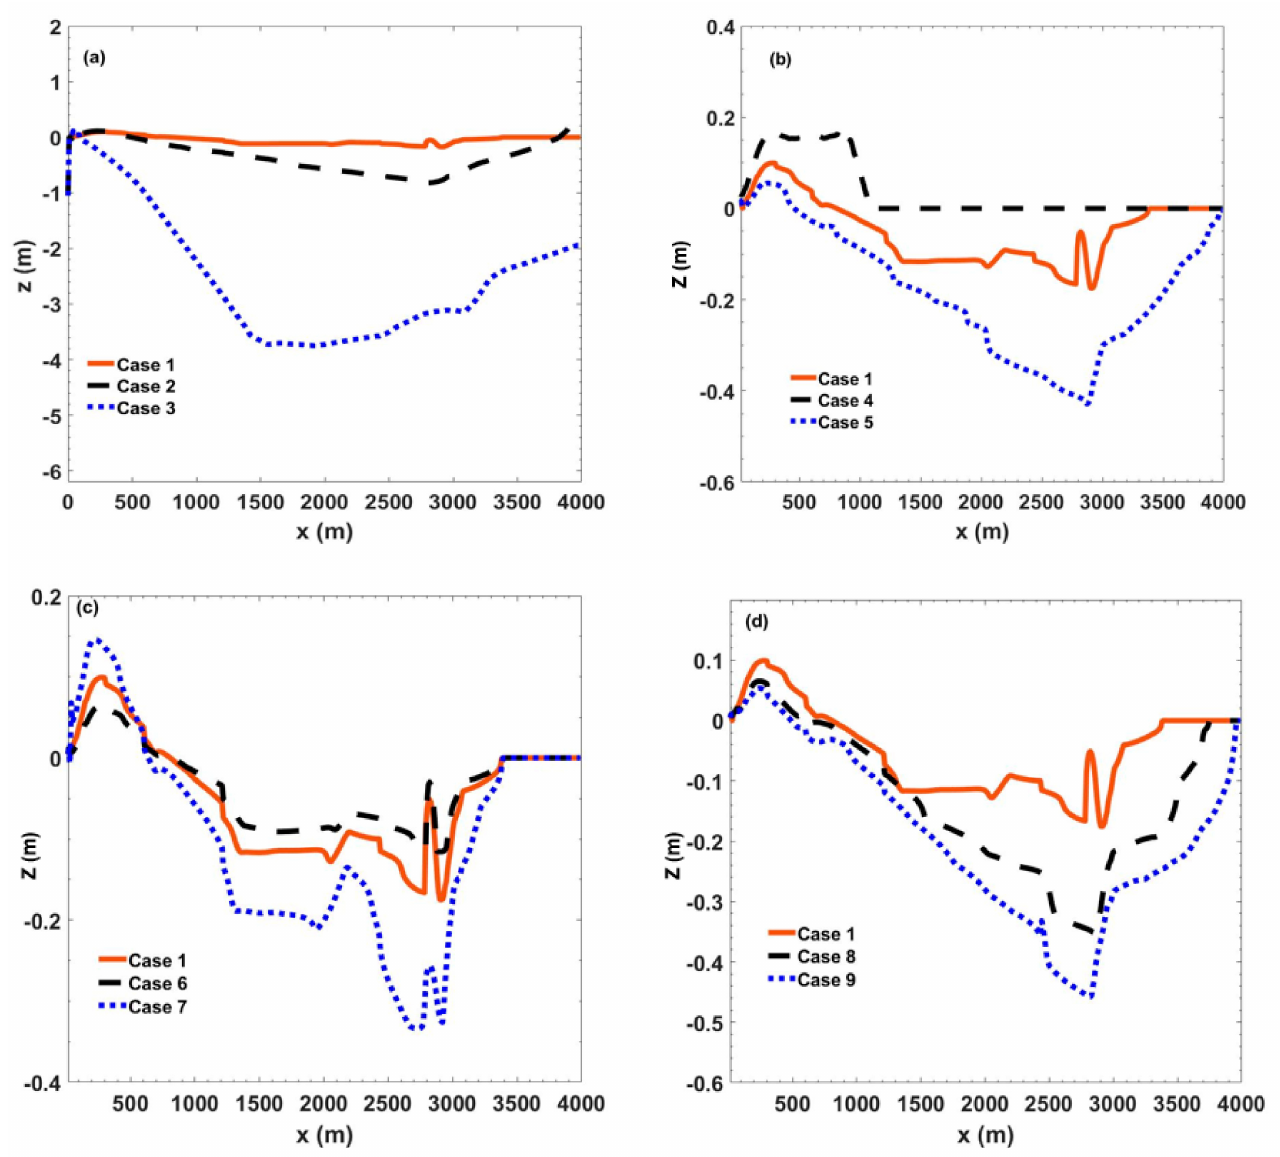
Figure 10. ( d ) Comparisons of the evolution of the sediment bed. ( a ) different sediment sizes ( b ) different bed slopes, ( c ) different slopes, and ( d ) different